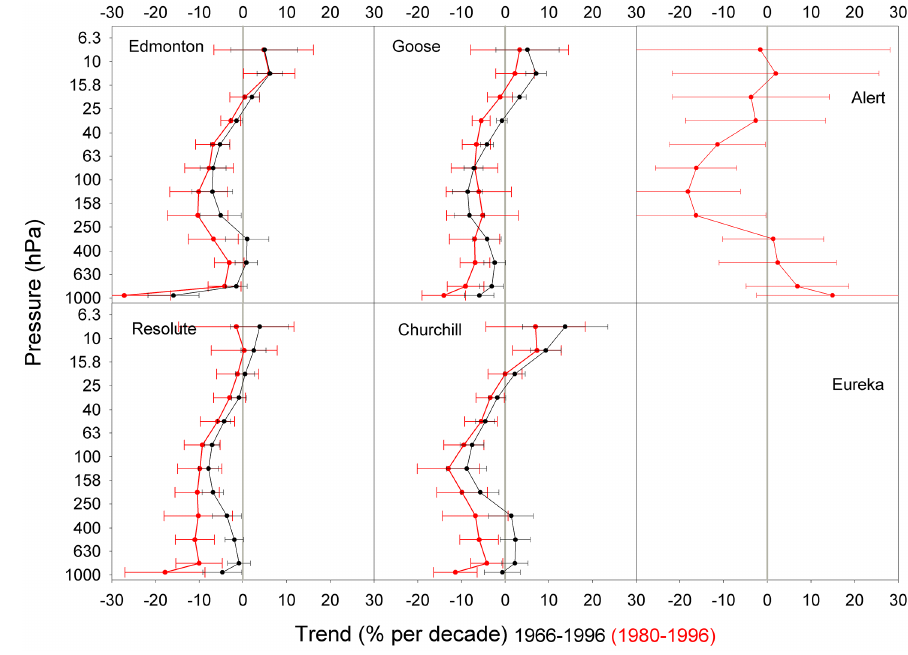
Figure 16. As Fig. 15 but for 1966–1996. Trends using only ECC data (from 1980) are shown in